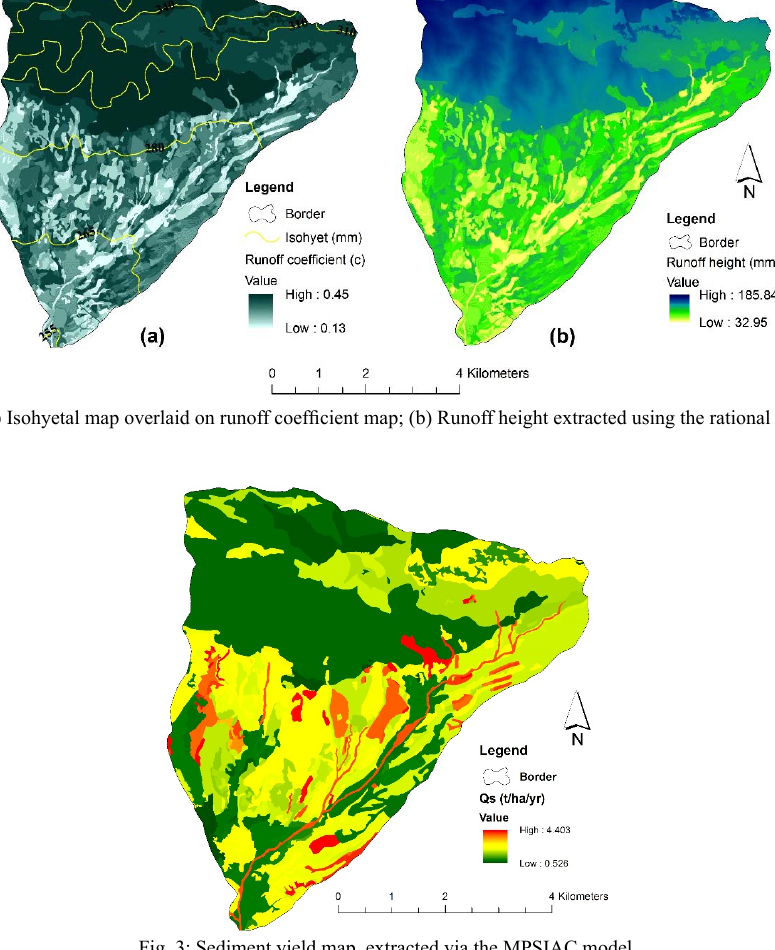
Fig. 3: Sediment yield map, extracted via the MPSIAC model